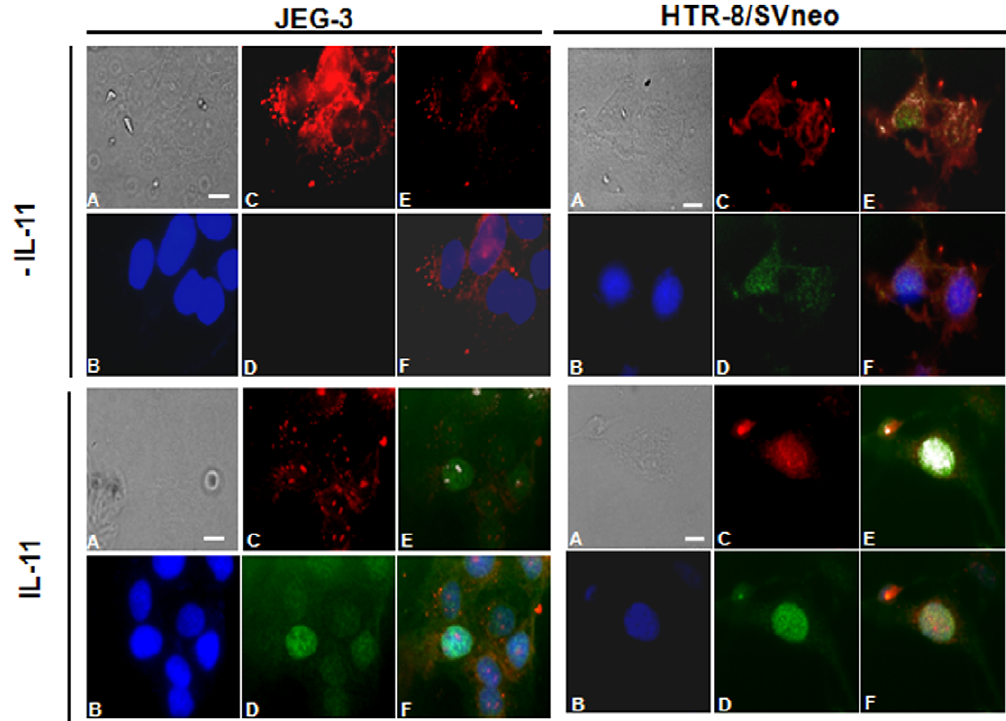
Figure 7. Immunolocalization of p-STAT3 (tyr705) and PIAS1/3 in JEG-3 and HTR-8/SVneo cells following IL-11 treatment. JEG-3 and HTR-8/SVneo cells were treated with IL-11 (200 ng/ml) for 10 min and then checked for the immunolocalization of p-STAT3 and PIAS1/3 followed by counter staining with DAPI. In the figure sub-panels are: A; phase contrast image, B; DAPI stained cells, C; staining for PIAS1/3, D; staining for p- STAT3(tyr705), E; co-localization of p-STAT3(tyr705) and PIAS1/3, F; merge image of the PIAS1/3, p-STAT3(tyr705) and DAPI images. Co-localization performed for PIAS1/3 and p-STAT3(tyr705) signals using ‘‘co-localization tool’’ of the ImageJ software. Two points are considered as co-localized, if their respective intensities are strictly higher than the threshold of their channels. Each co-localization point appears as white dot. Scale bar represents 20 m m size.